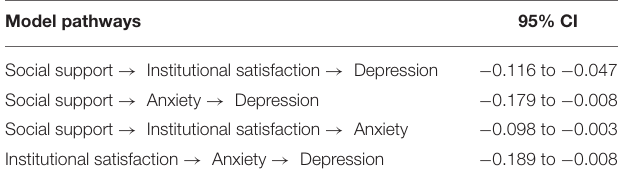
TABLE 6 | Significance of mediating